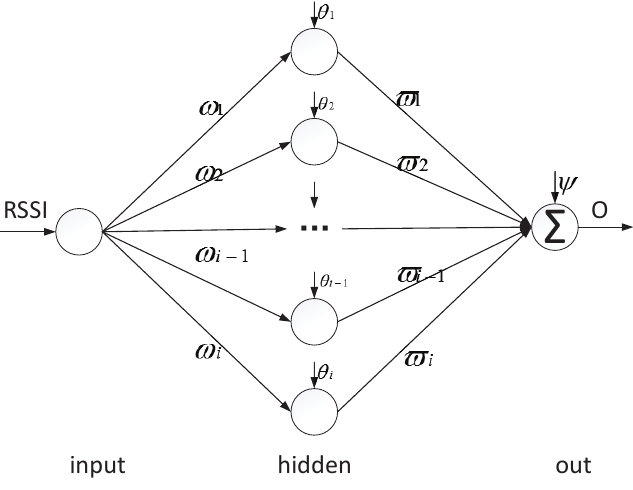
Figure 5. Neural network